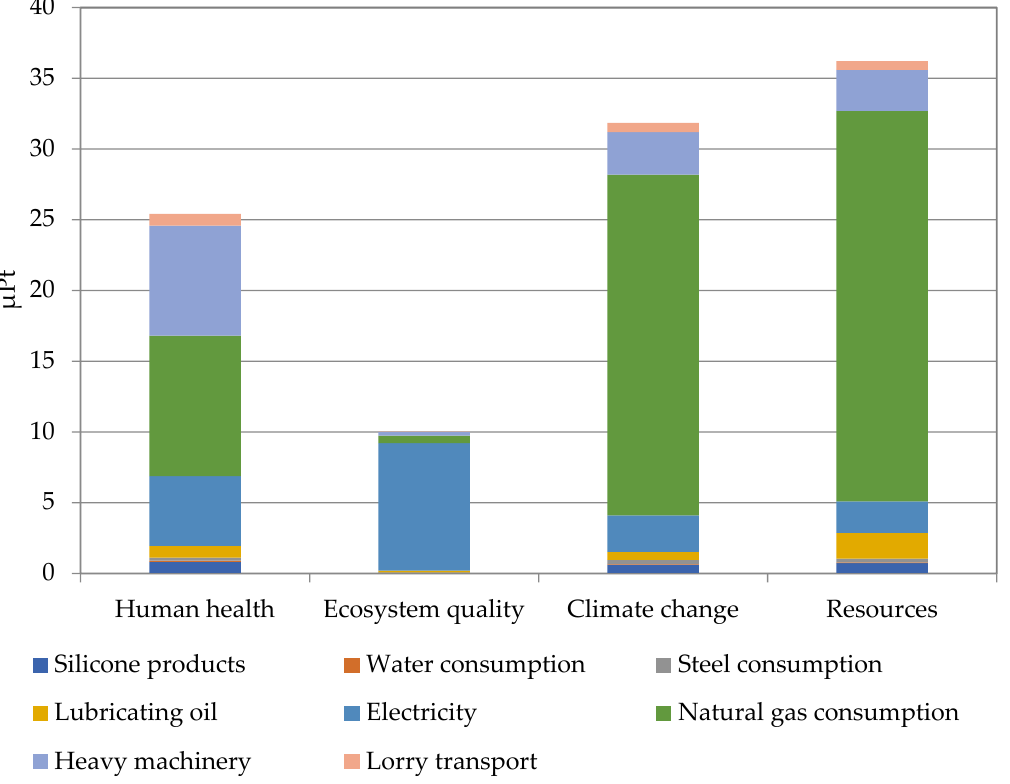
Figure 3. Endpoint impacts of basalt fiber production.